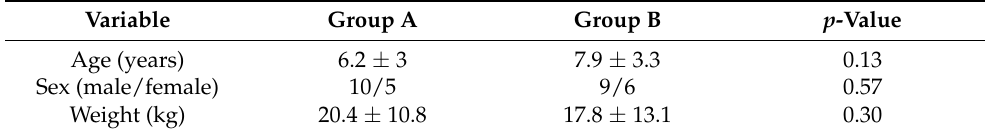
Table 3. Characteristics of the 30 dogs participating in the clinical trial. All characteristics reflect baseline values immediately before study enrollment.